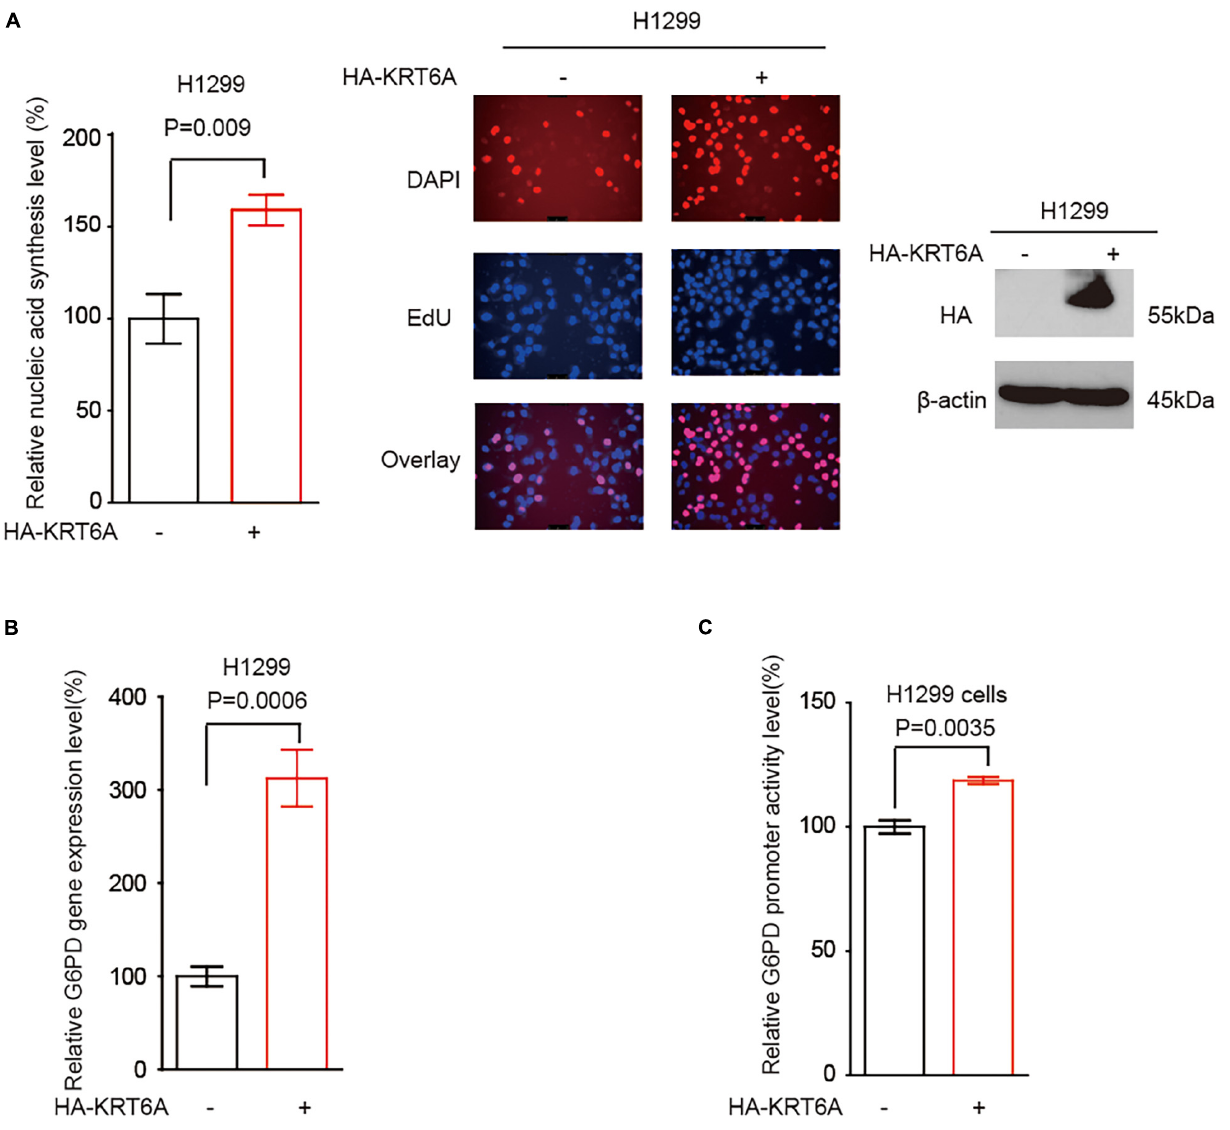
FIGURE 5 | KRT6A promotes G6PD expression. (A) DNA synthesis was quantified in H1299 cells overexpressing KRT6A or an empty vector. (B) Determination of G6PD expression levels by Real-time PCR in KRT6A overexpressing and control H1299 cells. (C) Determination of G6PD promoter activity in KRT6A overexpressing and control H1299